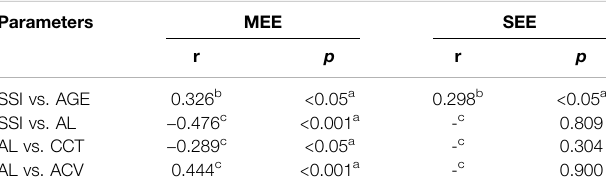
TABLE 4 | Partial correlation coef fi cient adjusted for age between ocular parameters of the two groups.